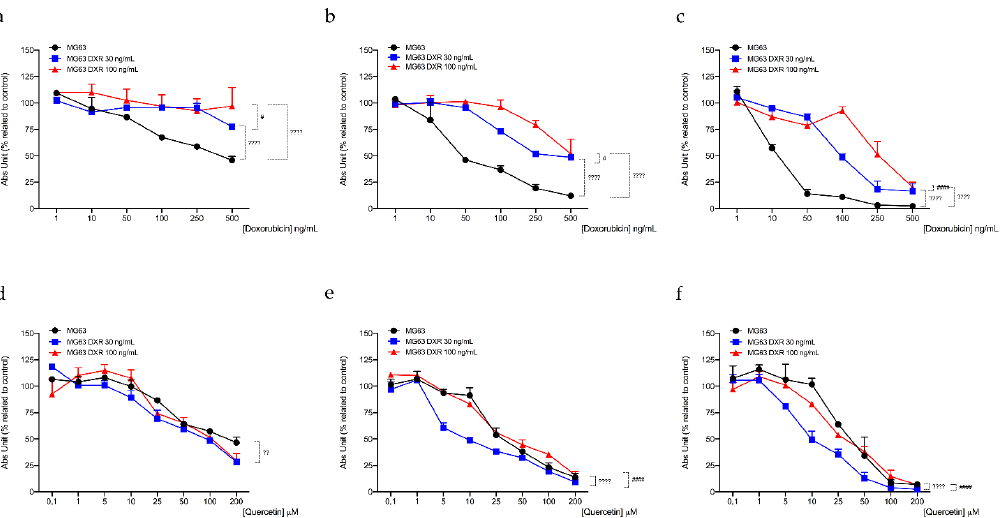
Figure 7. Evaluation of cell viability in MG63, MG63 DXR 30 ng/mL, and MG63 DXR 100 ng/mL following treatment with DXR ( a – c ) and quercetin combined with DXR 30 and 100 ng/mL, respectively ( d – f ) for 24 ( a – d ), 48 ( b – e ), and 72 h ( c – f ). Data represent mean ± SD of three different experiments. ** p < 0.01, **** p < 0.0001, resistant “vs.” sensitive cells; # p < 0.05, #### p < 0.0001, DXR100 “vs.” DXR 30 clones.